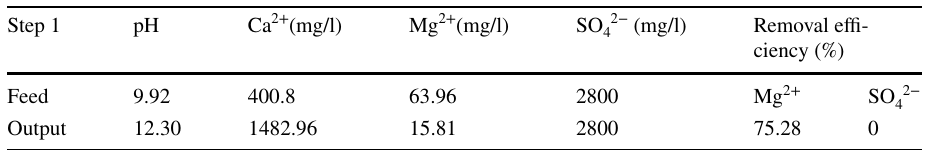
Table 3 Results of first step